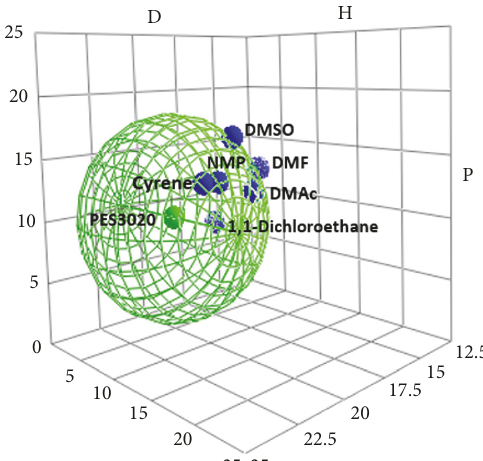
Figure 1: Recommended solvents mapped in Hansen space with solubility sphere for PES3020. Hansen solubility parameters are given here in units of MPa 1/2